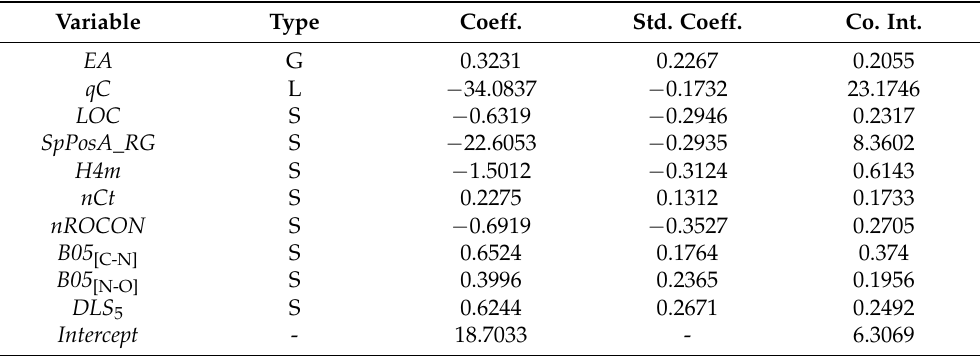
Table 2. Best obtained model, where G, L, and S means global, local, and structural descriptors respectively, Coeff mean coefficient, Std. Coeff is the standardized coefficient and Co. Int. is the confidence interval at 95%. Type Coeff.